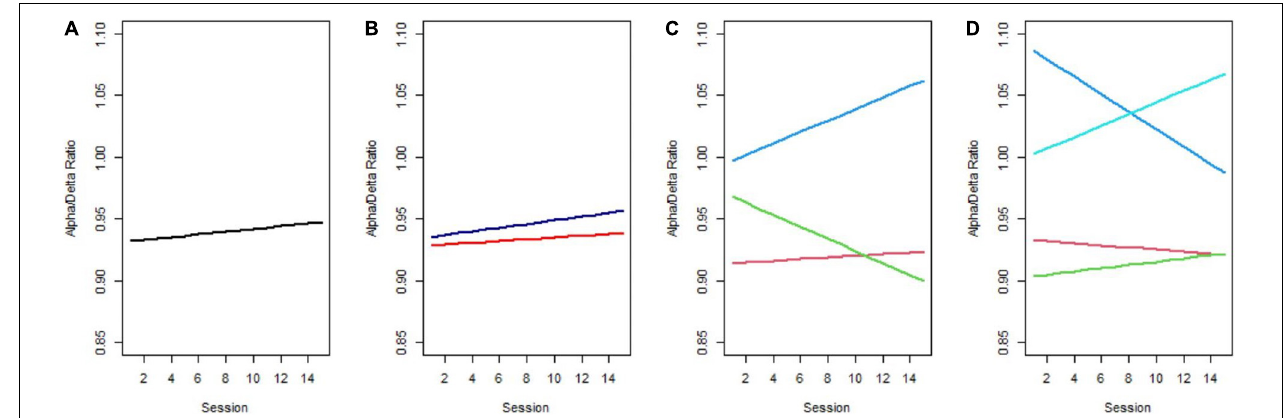
FIGURE 3 | Predicted trajectories across 15 NFB training sessions. (A) 1-Class model, (B) 2-class model, (C) the favored 3-class model, with Class 1 corresponding to the red, Class 2 to green, and Class 3 to the blue line, (D) 4-class model.